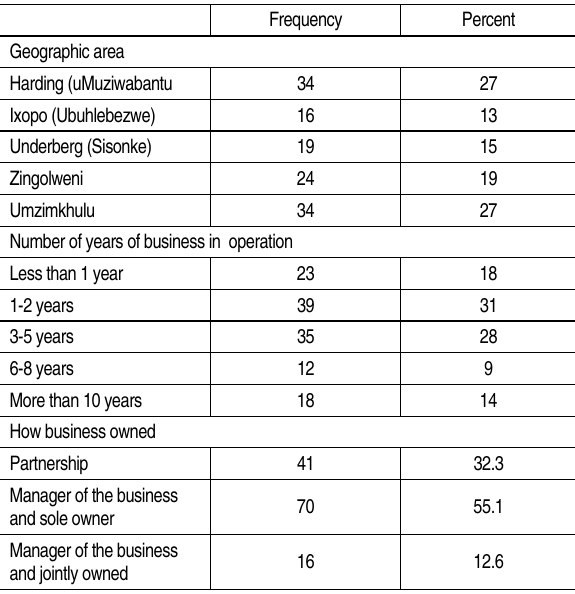
Table 1. Profile of usable sample as per